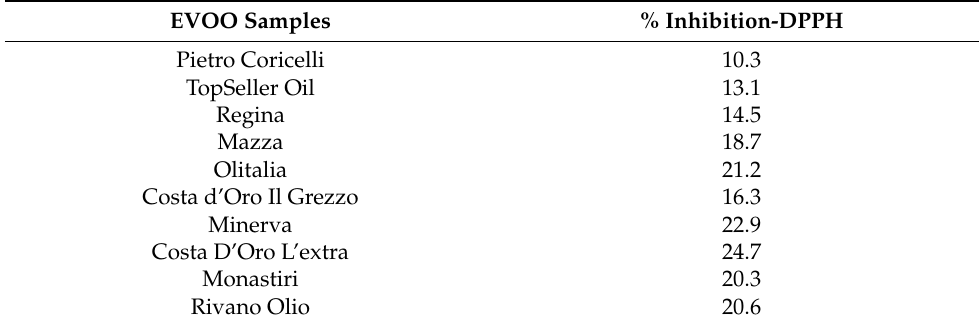
Table 6. Determination of antioxidant activity of the studied EVOO